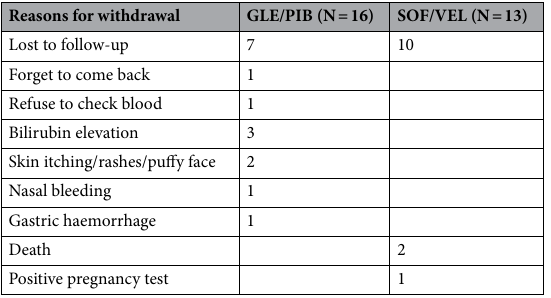
Table 2. Reasons for DAA withdrawal. DAA direct-acting antiviral; GLE/PIB glecaprevir/pibrentasvir; SOF/ VEL sofosbuvir/velpatasvir.